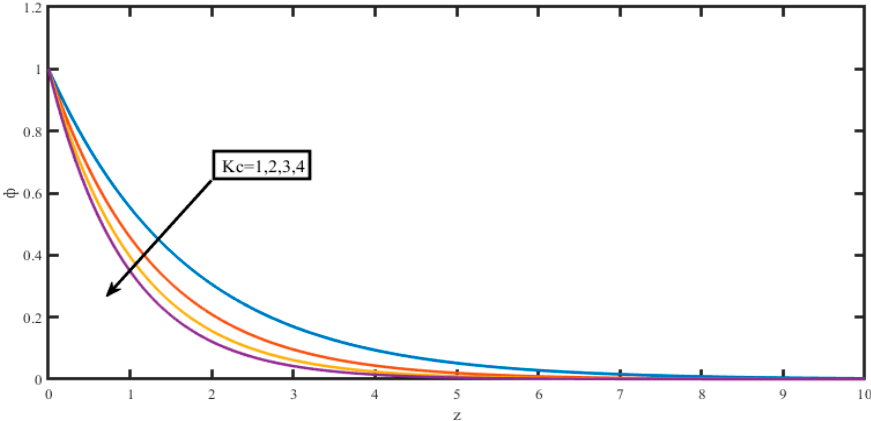
Figure 13. The influence of the Chemical reaction parameter Kc on the Concentration profiles.